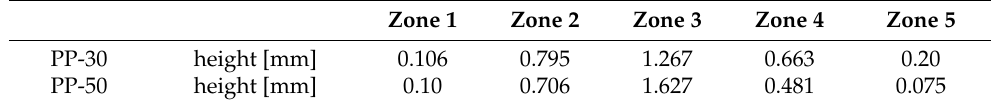
Figure 6. CT images and the course of the fiber-matrix volume ratio in the height direction of the flow spiral as a function of the wood content at the beginning of the flow path. Table 4. Heights of the five flow layers determined from